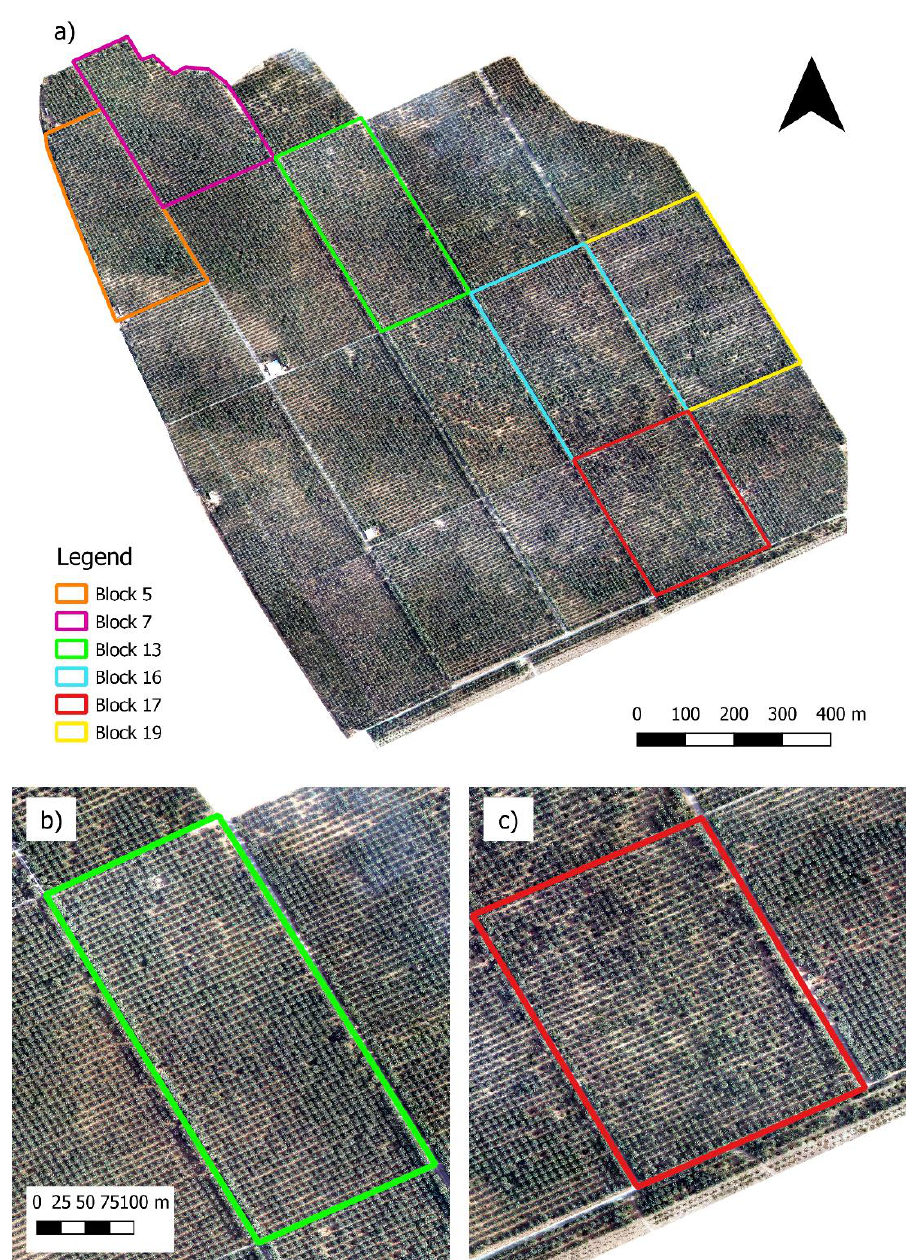
Figure 2. ( a ) Shows the selected test blocks; Blocks 5, 7, and 13 have been classified as healthy and Blocks 16, 17 and 19 have been classified as unhealthy. ( b ) and ( c ) shows an example of blocks classified as healthy (green) and unhealthy (red)